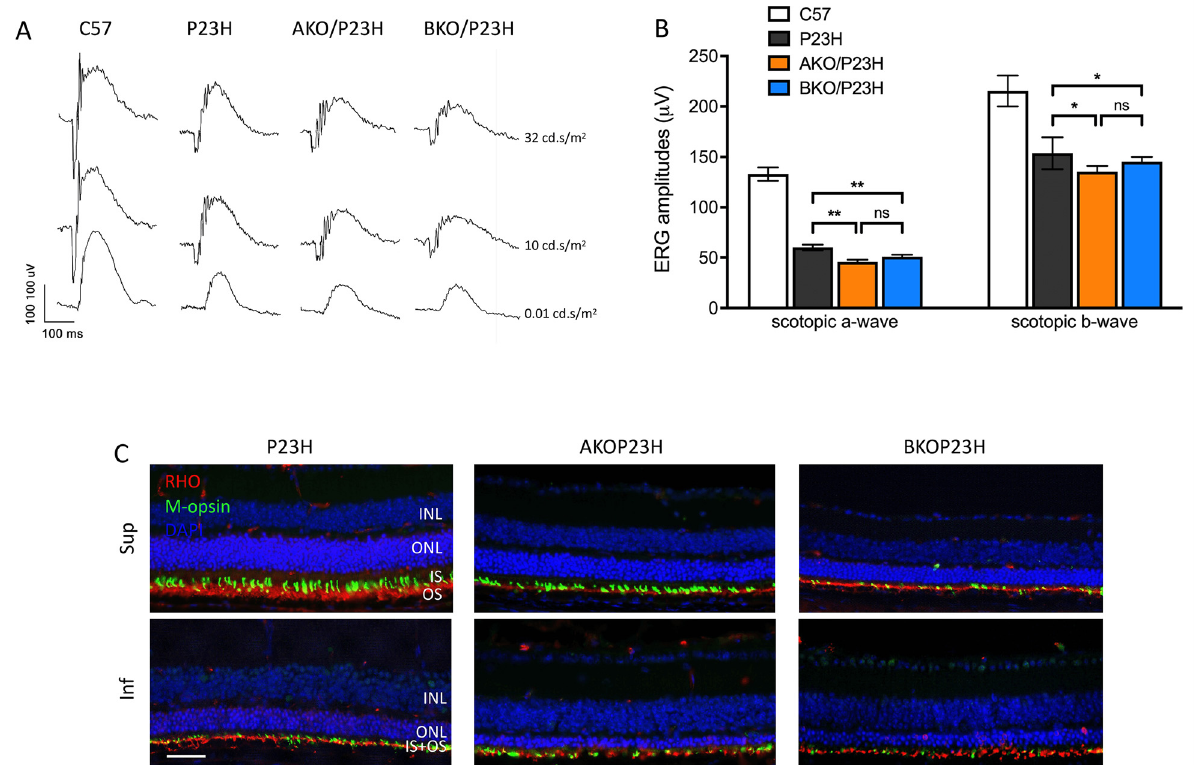
Figure 2. Decreased retinal function in AKO/P23H and BKO/P23H mice. ( A ) Representative scotopic ERG traces at indicated intensity in AKO/P23H, BKO/P23H, P23H and wild-type C57 mice at 4 months of age. ( B ) Quantification of amplitudes of scotopic a-wave and b-wave at the intensity of 10 cd s/m 2 at 4 months of age confirms the reduction in retinal function corresponding to the increase in photoreceptor cell death. ( C ) Representative immunofluorescent staining images of superior and inferior retina of four-month-old AKO/P23H, BKO/P23H, and P23H mice, stained for rhodopsin (RHO in red), m-opsin(green), and 4 ′ ,6-diamidino-2-phenylindole (DAPI in blue) confirm the reduction in photoreceptive elements corresponding to the increase in photoreceptor cell death. Scale bar: 50 µm. (n = 12), * p < 0.05; ** p < 0.01; ns, not significant; one-way ANOVA. INL, inner nuclear layer; ONL, outer nuclear layer; IS, inner segment; OS, outer segment.